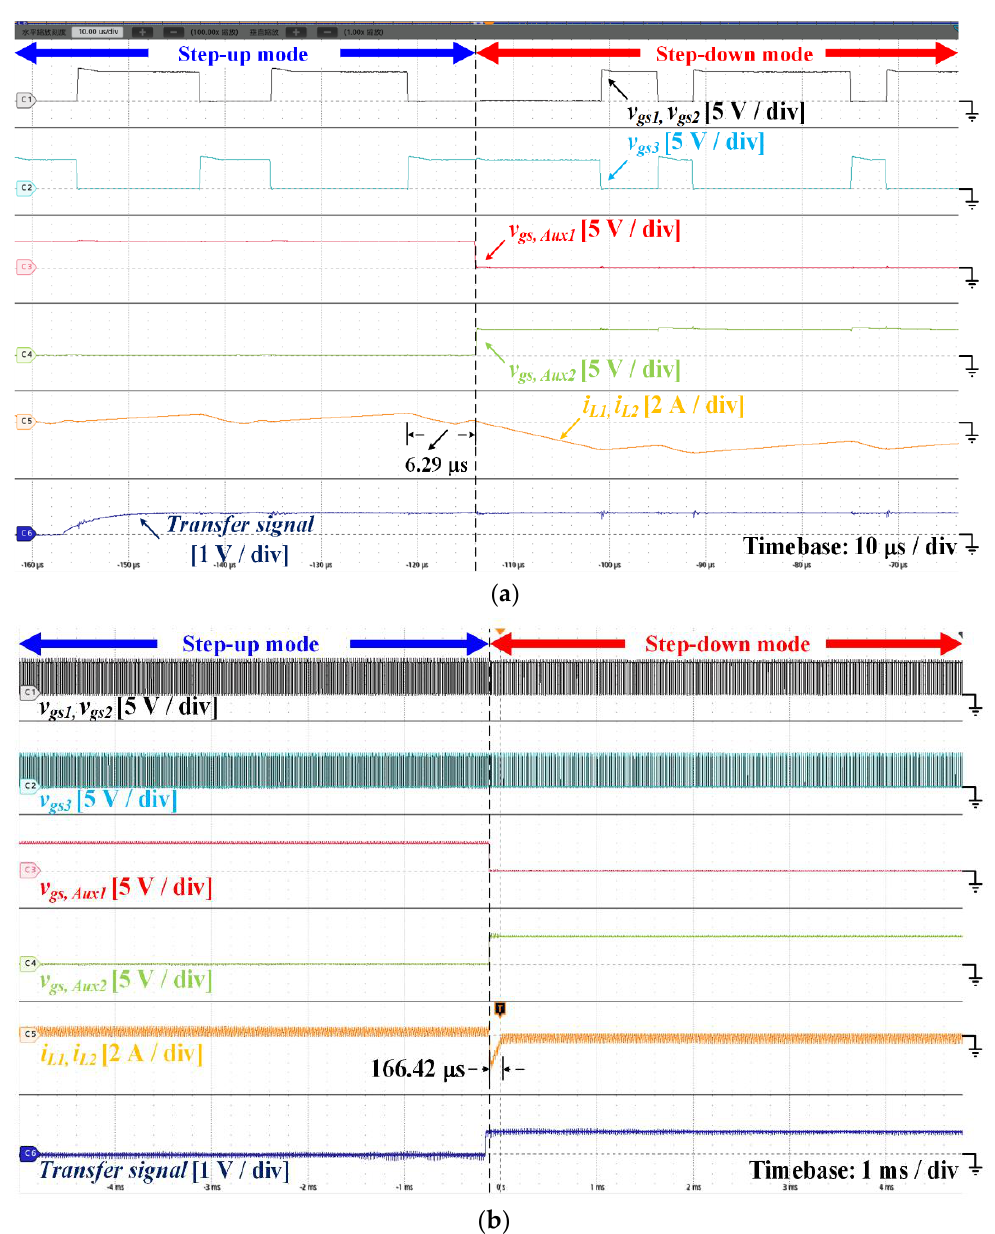
Figure 19. Experimental results of dynamic performances with DCM load condition. ( a ) v gs 1 , v gs 2 , v gs 3 , v gs , Aux1 , v gs , Aux2 , i L1 , i L2 , transfer signal. ( b ) Change from the step-up mode to the step-down mode.